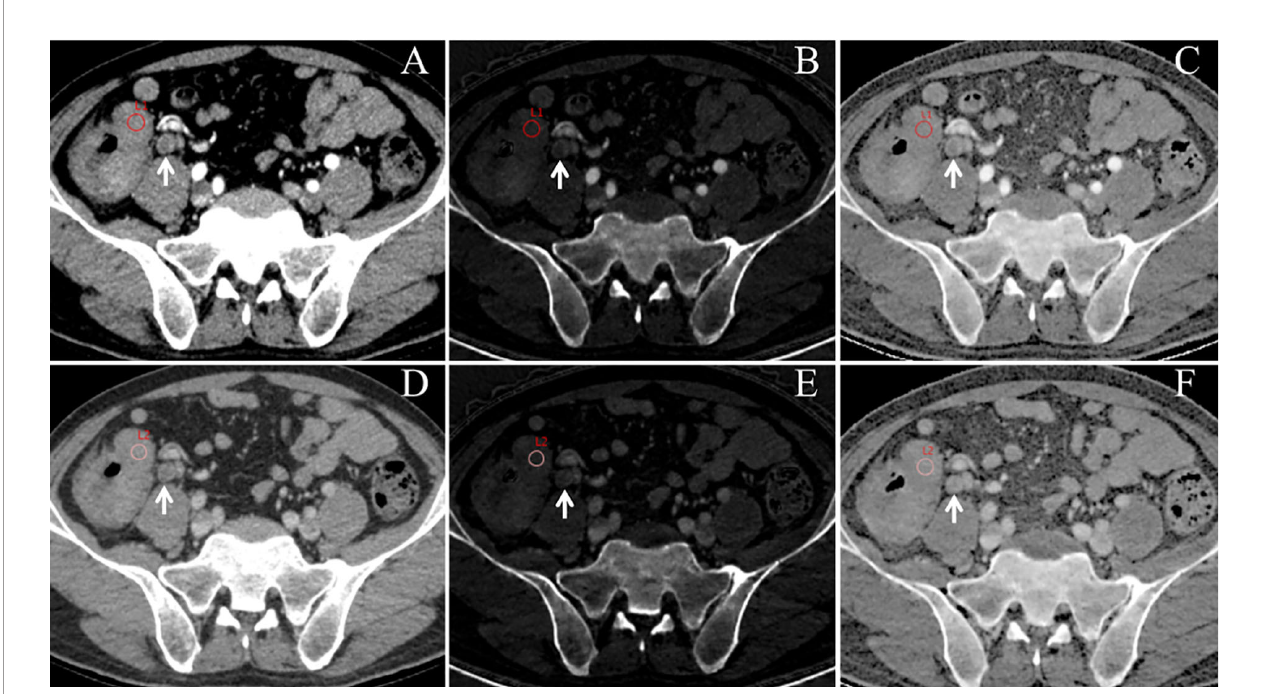
FIGURE 2 | An example of dual-energy spectral computed tomography (DESCT) images with regions of interest (ROIs) for evaluating quantitative measurements in a 63-year-old man with ascending colon cancer that was pathologically con fi rmed to have lymph node metastasis (LNM). ROIs were placed in the arterial phase (A) and the venous phase (D) of the 70-keV monochromatic images. Concurrently, ROIs were copied to the arterial phase (B) and the venous phase (E) of iodine-based material decomposition images and the arterial phase (C) and the venous phase (F) of the effective atomic number images. Local lymphadenopathy is presented in front of the right psoas major (white arrow) at both the arterial phase and venous phase (A – F)